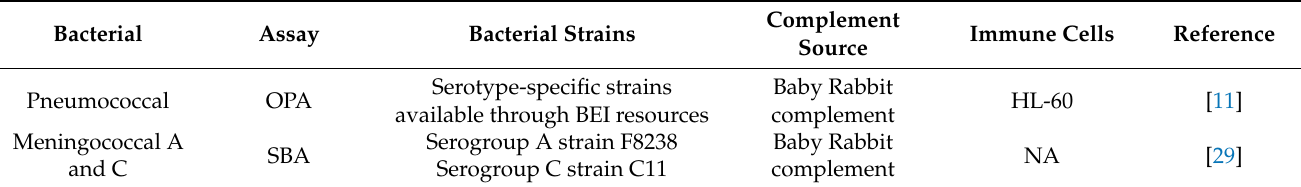
Table 3. Standardised OPA and SBA for evaluating pneumococcal and meningococcal ACYW vaccines.